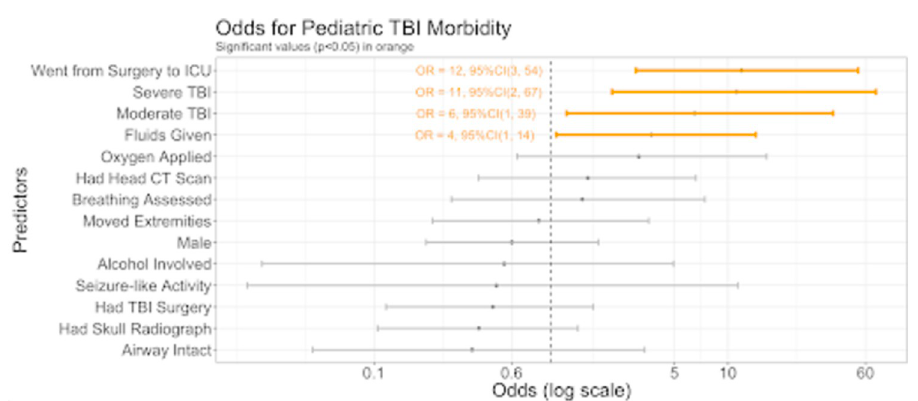
Fig 4. Odds of morbidity. The odds (on a log scale) of morbidity based on multivariable logistic regression for the pediatric TBI patients by each predictor variable.